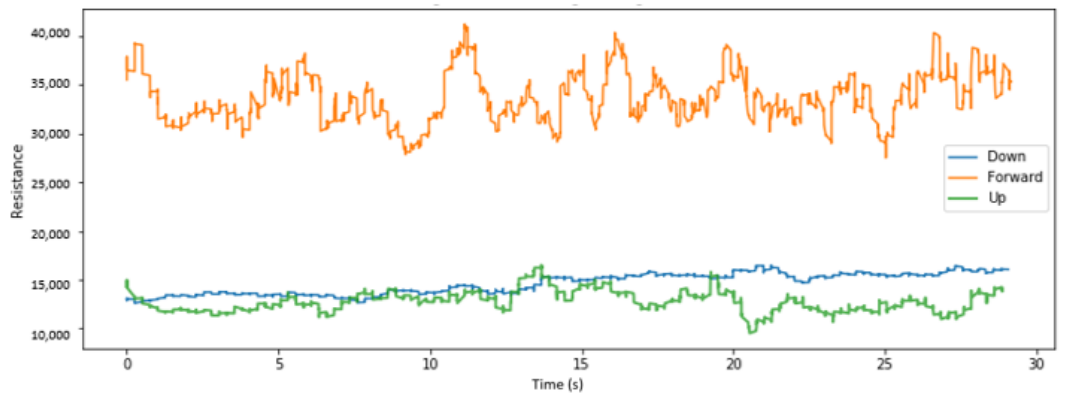
Figure 6. With high placement of short sensor, head tilt filtered data.